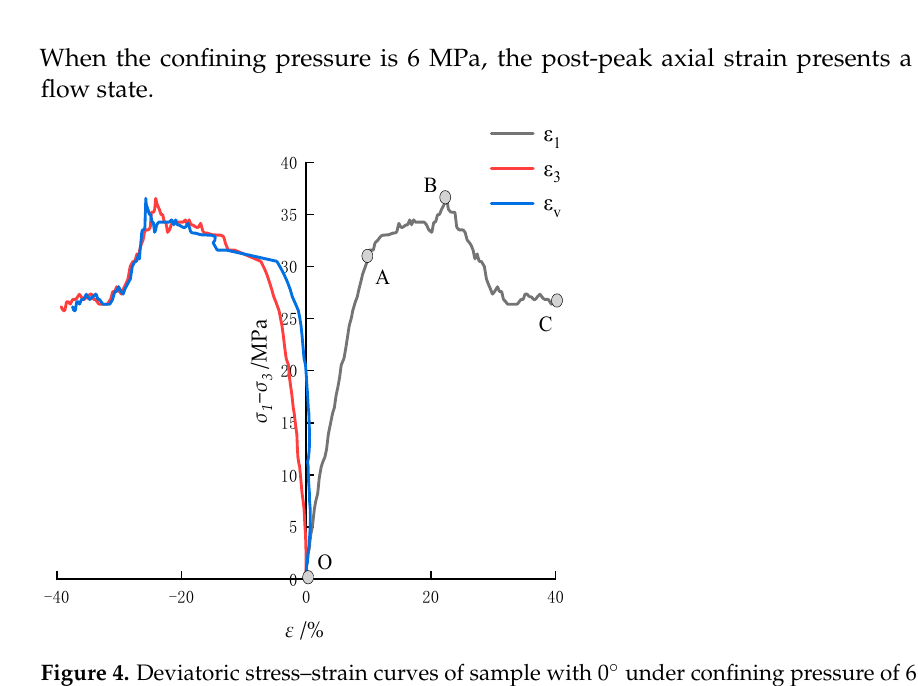
Figure 4. Deviatoric stress–strain curves of sample with 0° under confining pressure of 6 MPa.